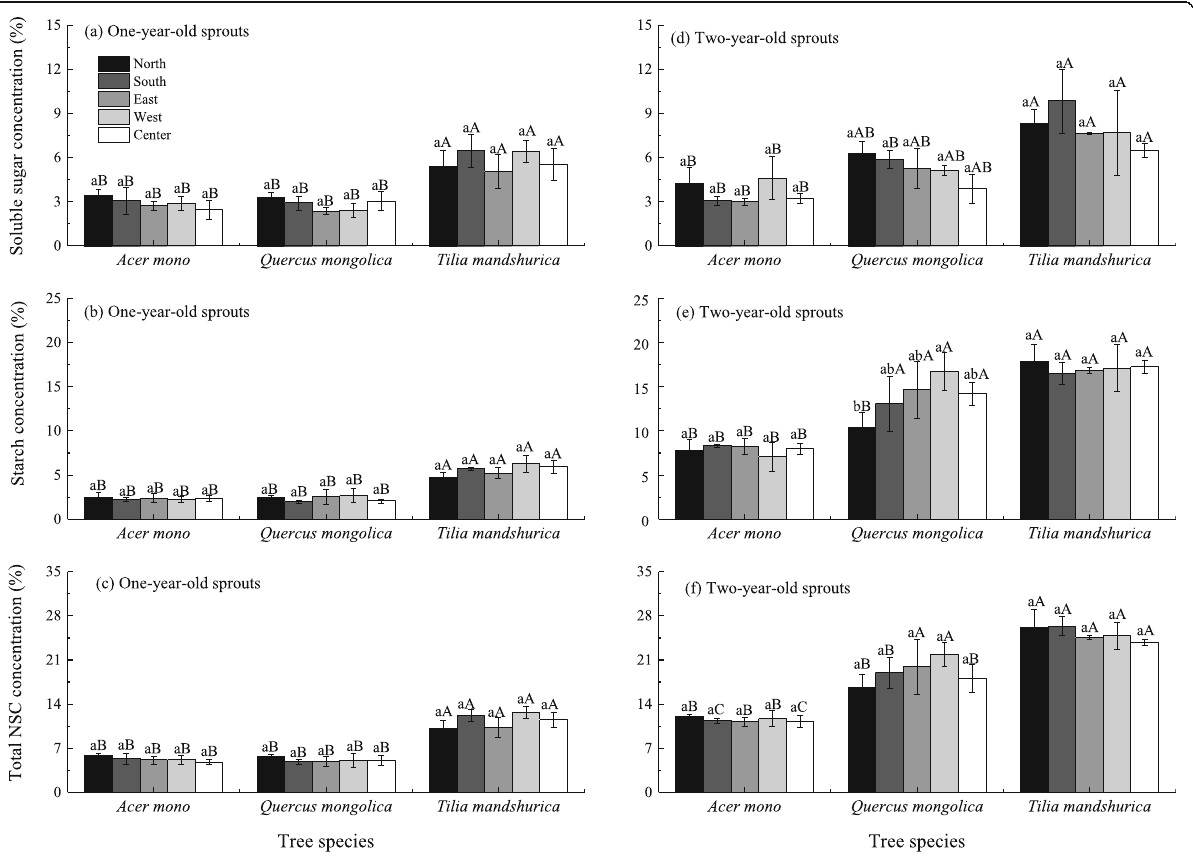
Fig. 5 Concentrations of stem NSCs (soluble sugar, starch, and total NSC) in 1-year-old and 2-year-old sprouts at different within-gap positions for three tree species. The data are presented as the mean ± S.D. Different capital letters indicate significant differences ( P < 0.05) among tree species. Different lowercase letters indicate significant differences ( P < 0.05) among within-gap